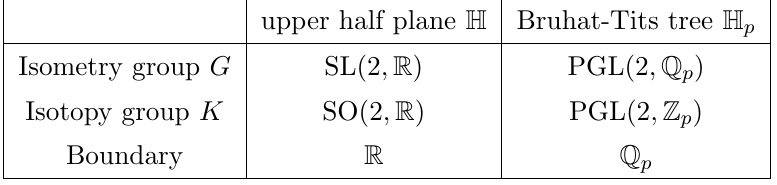
Table 1. The parallel between the upper half plane H and the Bruhat-Tits tree H p